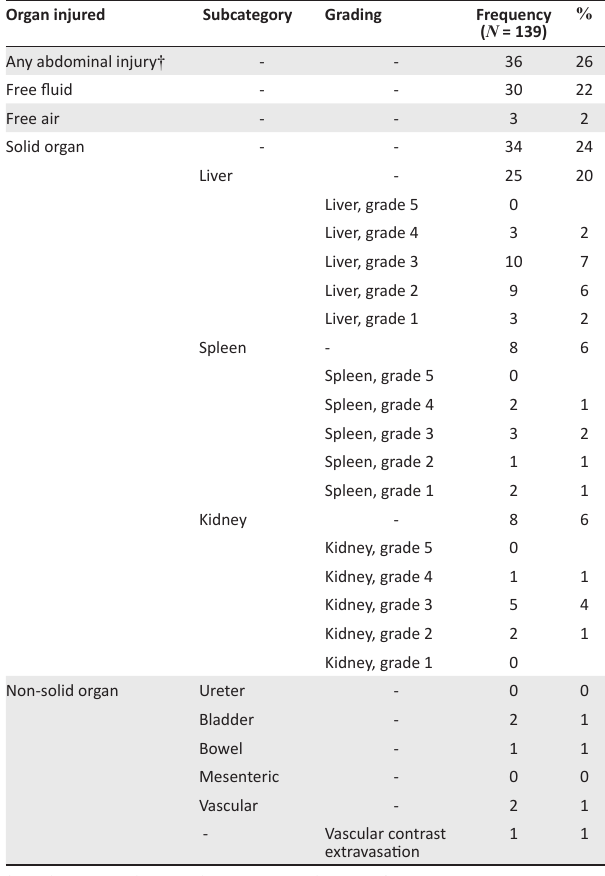
TABLE 3: Computed tomography abdomen